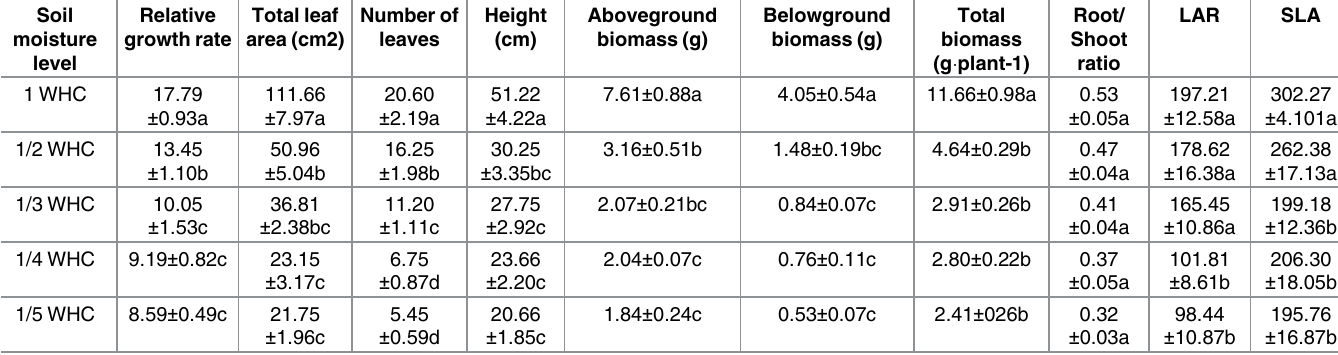
Table 3. Effects of water condition on the growth parameters of Nyssa yunnanensis seedlings. Soil Relative Total leaf Number of moisture growth rate area (cm2) level